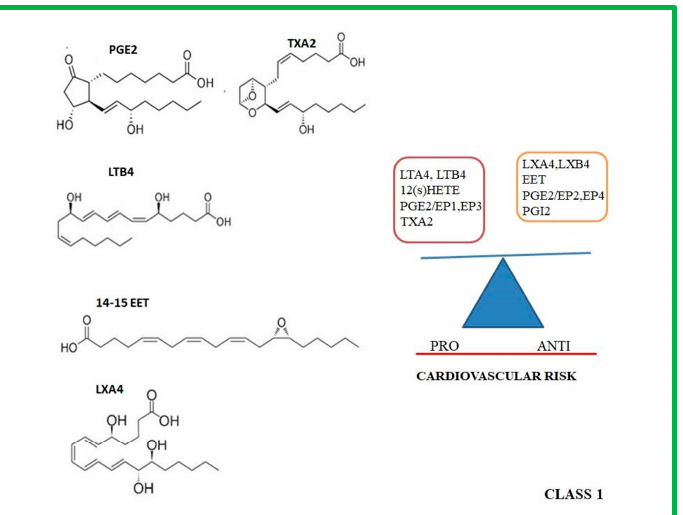
Figure 1. Molecular structure of the principal class 1 lipid mediators (on the left). On the right, the class 1 lipid mediators are divided according to their anti and pro cardiovascular risk proper- ties.PGE2: prostaglandin E2; TXA2: thromboxane A2; 14-15 EET: 14-15 epoxyeicosatrienoic acid; LTB4: Leukotriene B4; LXA4: Lipoxin A4; 12(S)-HETE:12-hydroxyeicosatetraenoic acid;